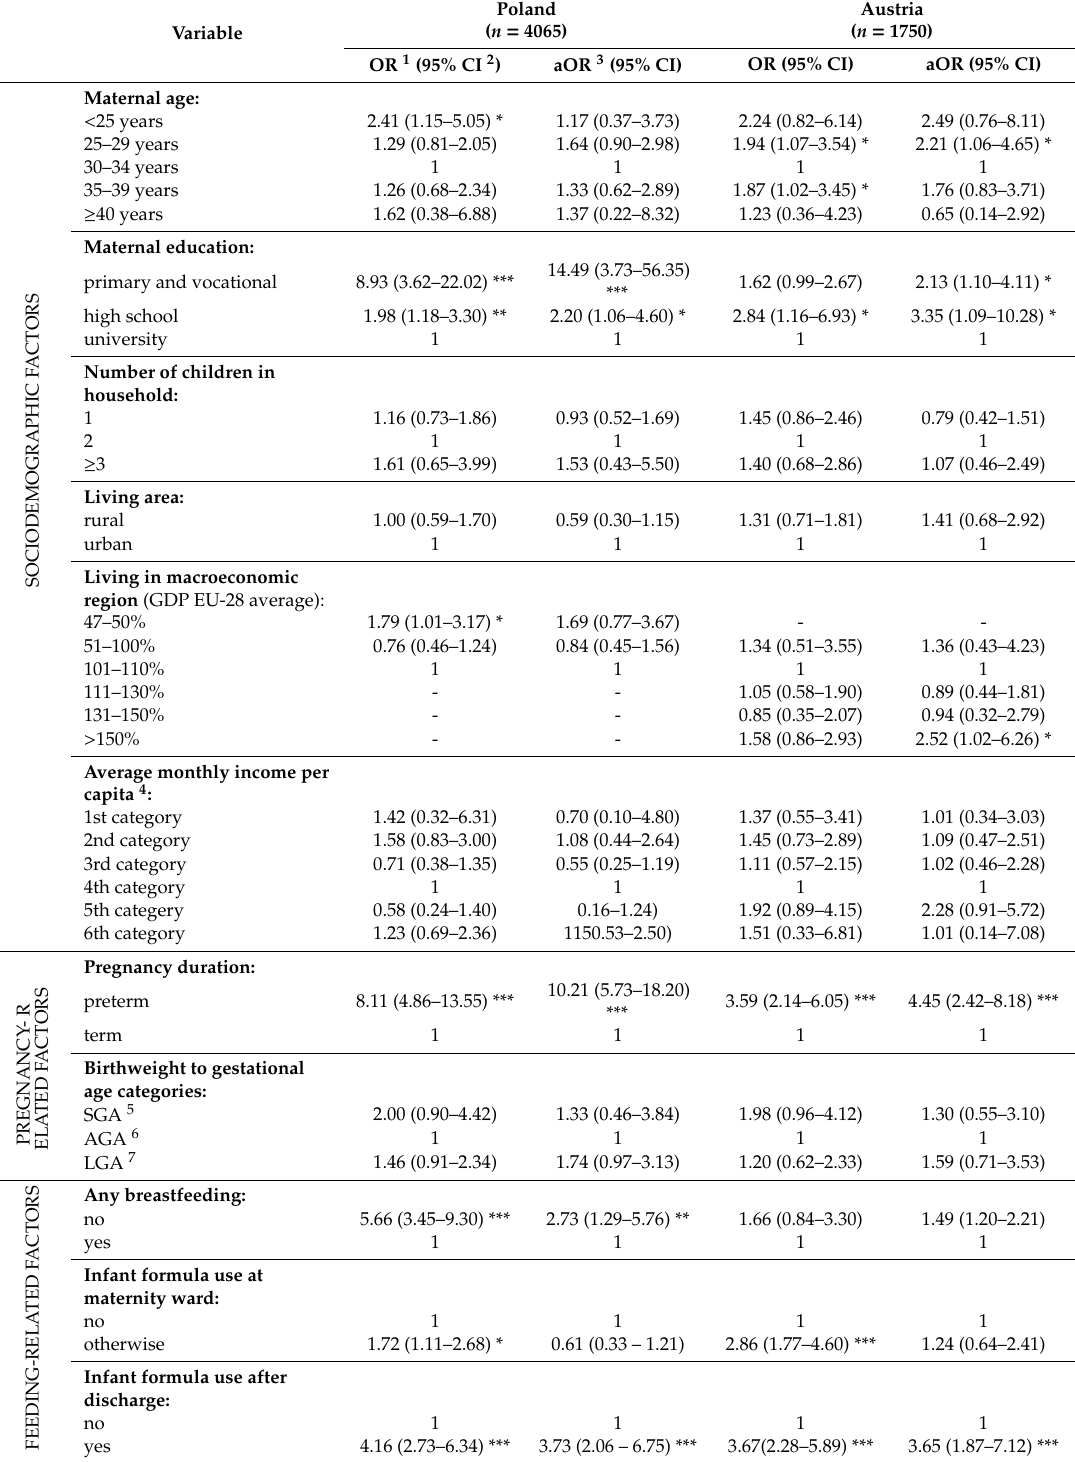
Table 3. Univariateandmultivariateregressionanalysismodelsoffactorsinfluencingthecomplementary feeding start before 4